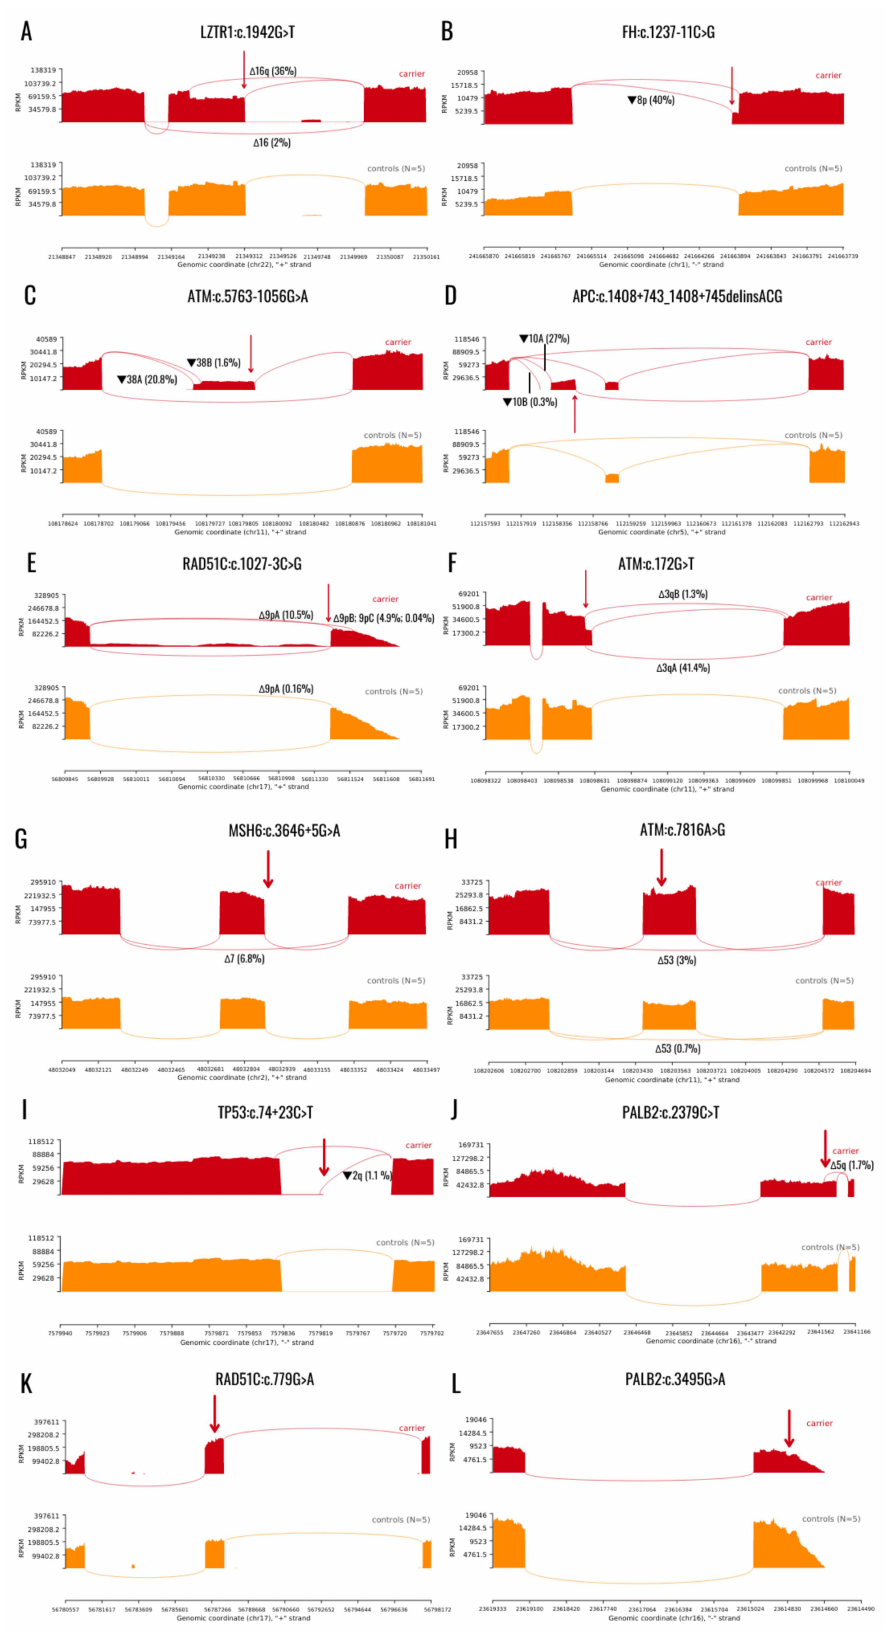
Figure 1. Sashimi plots representing variant’s impact on splicing. Variant ( A ) u LZTR1